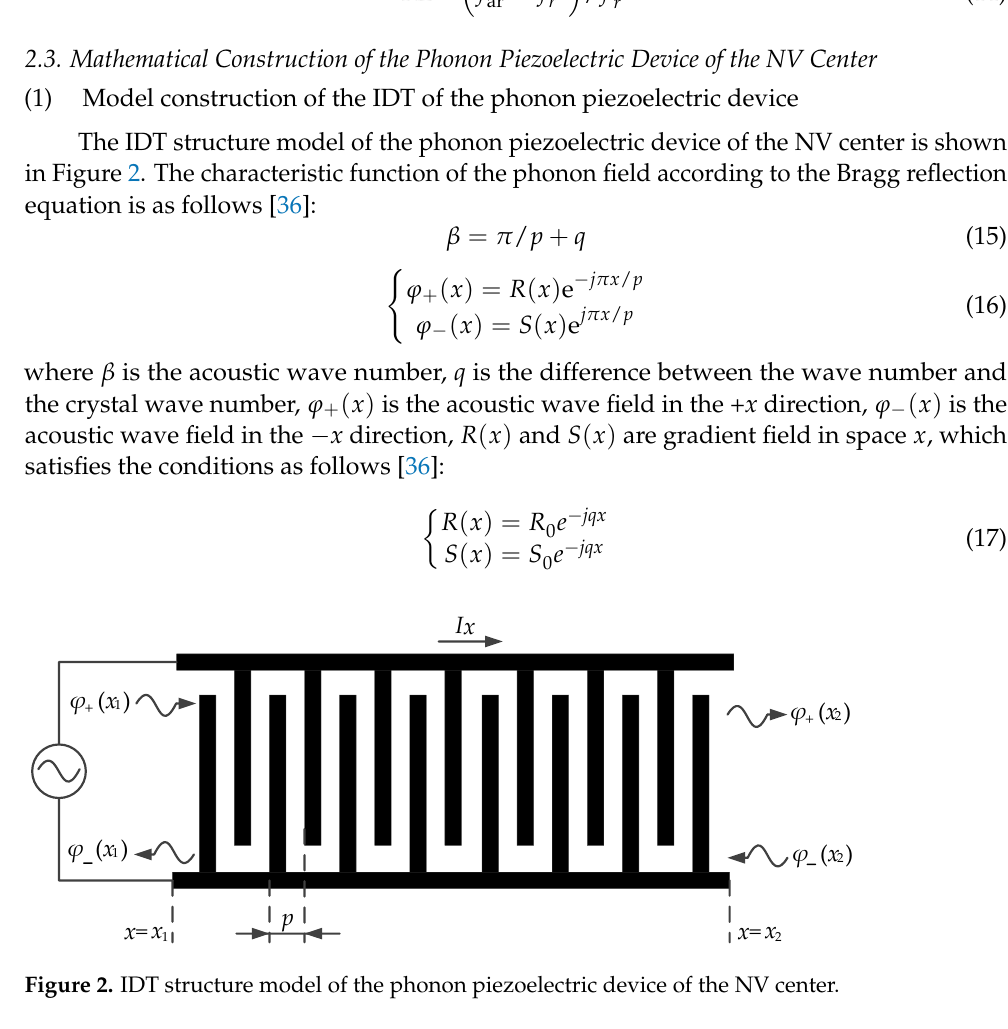
Figure 3. Structural unit model of phonon piezoelectric device and ZnO microstructure. ( a ) Struc- tural unit model of phonon piezoelectric device; ( b ) the crystal structure of ZnO; ( c ) a plot of rotation coordinate of ZnO. The potential, Rayleigh, Sezawa, and Love wave distribution of the phonon piezoe- lectric device are shown in Figure 4a – d. The potential distribution on the surface of the X(a)